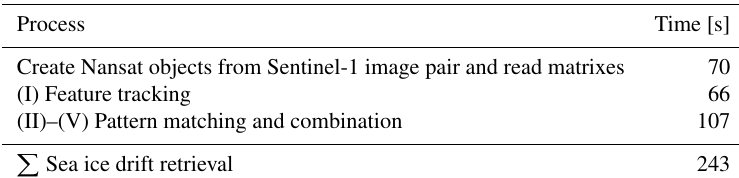
Table 2. Processing time for sea ice drift retrieval from image pair Fram Strait on a grid with 4km (50 pixels) spacing using HV polarisation (Fig. 4). Representative for an image with large overlap and good coverage with feature-tracking